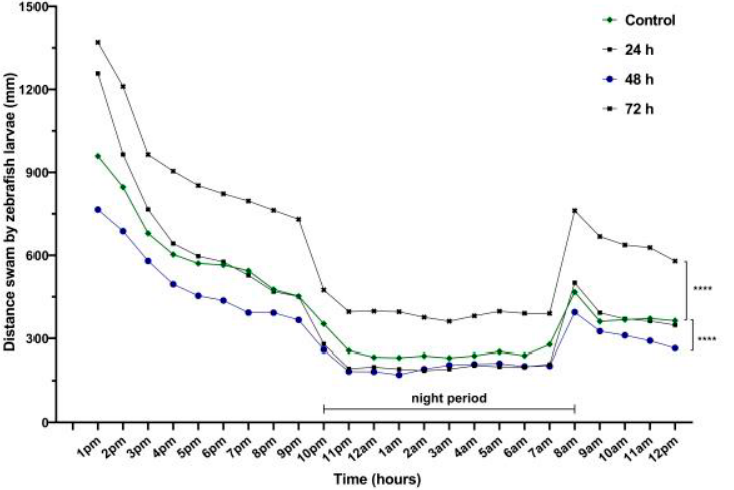
Figure 3. The total distance swam by 6-day-old zebrafish larvae recorded during 24 h ( n = 30). Group 1, control; Group 2, group exposed for 24 h to VPA; Group 3, group exposed for 48 h to VPA; and Group 4, group exposed for 72 h to VPA. The data is represented as average ± SEM. Anova and Tukey post-hoc tests, p < 0.05 was considered to be significant. The experimental groups were compared to control group, where **** p < 0.0001.